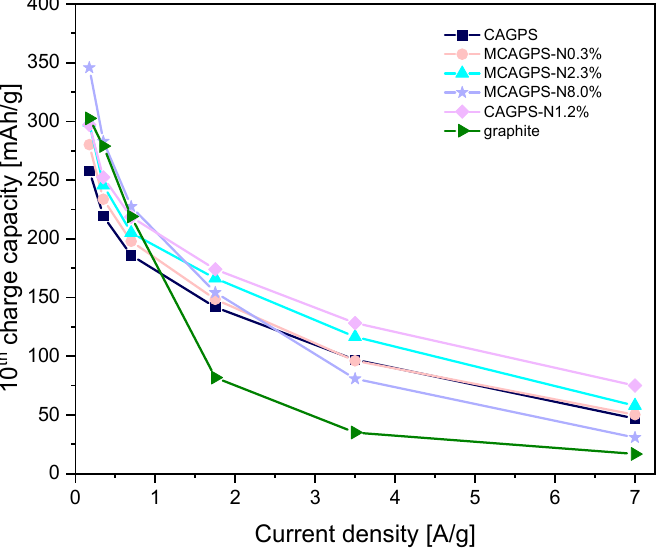
Figure 3. Charge capacity of every 10th cycle as a function of current density (MCAGPS—carbon aerogel made from potato starch modified with melamine; CAGPS-N—carbon aerogel made from potato starch modified by N 2 pyrolysis; CAGPS—pristine carbon aerogel).